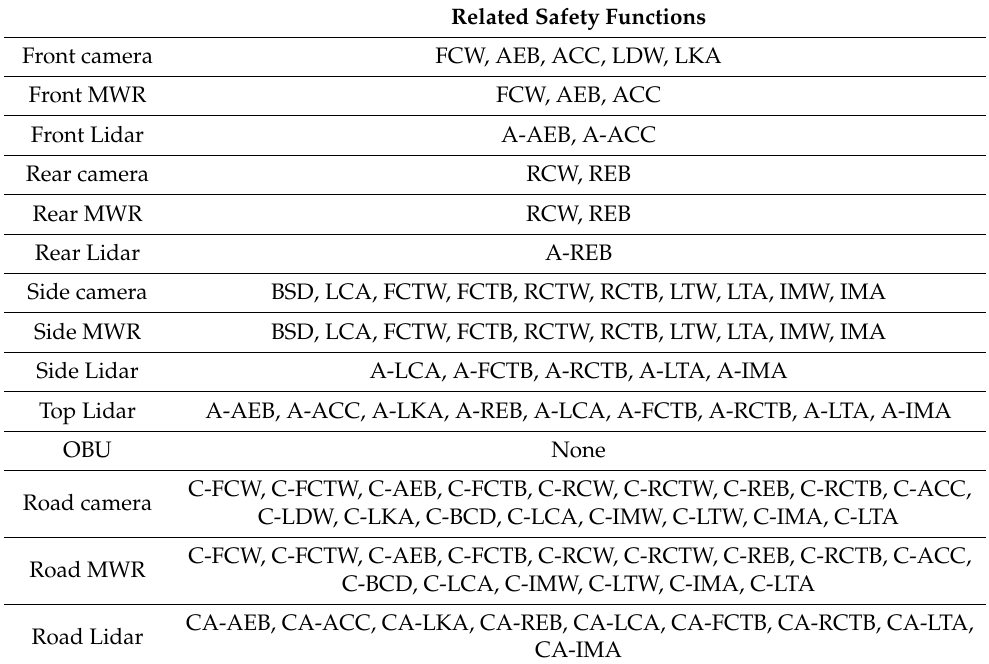
Table 1. The relationships between “atomic” technologies and corresponding safety functions. Related Safety